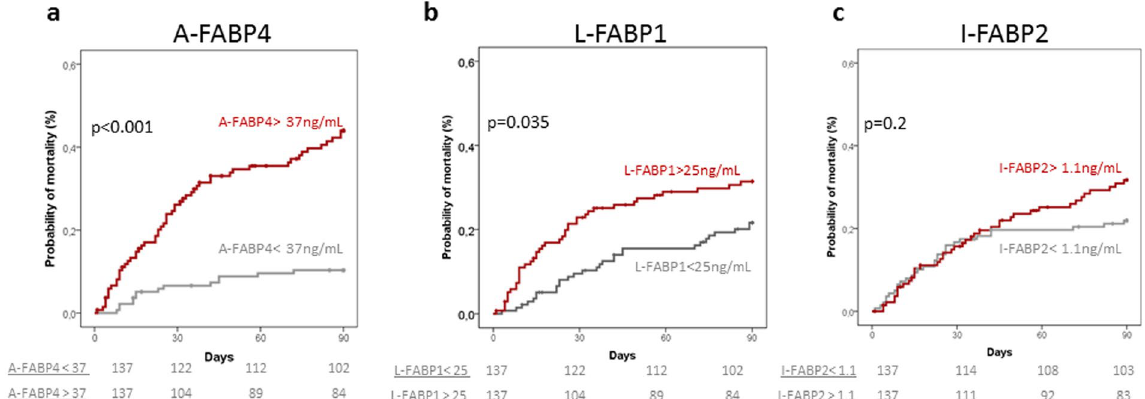
Figure 2. 90-day probability of mortality in all patients categorized according to median values of FABPs. A-FABP4: adipocyte fatty-acid binding protein 4, L-FABP1: liver fatty-acid binding protein 1 and I-FABP2: intestinal fatty-acid binding protein 2. Units of median values of FABPs are expressed in ng/mL.